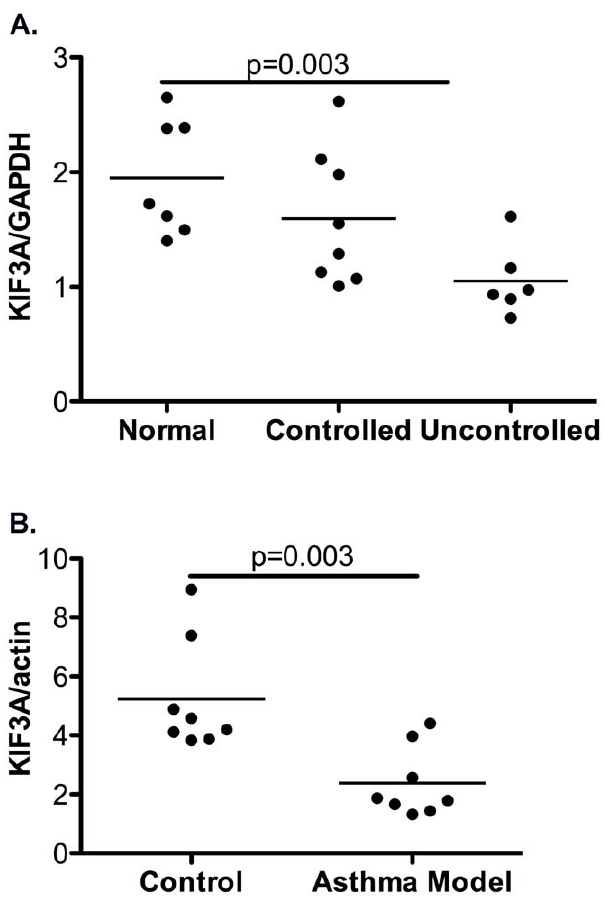
Figure 4. KIF3A gene expression of human epithelial RNA from children with uncontrolled asthma and of mouse models with asthma is decreased compared to controls. Gene expression of KIF3A in nasal epithelial-derived RNA from non-allergic children, controlled and uncontrolled asthmatics was determined by quantitative PCR. GAPDH was used to normalize for expression. To induce an asthma-like phenotype, wild type Balb/c mice were sensitized and challenged with 100 m g of house dust mite (asthma model) and compared to mice sensitized and challenged with phosphate buffered saline (control). One day post-treatment, RNA was extracted from lungs and gene expression measured by quantitative PCR. Actin was used to normalize for gene